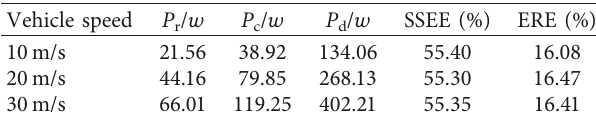
Table 6: Self-supply energy efficiency at different vehicle speeds.